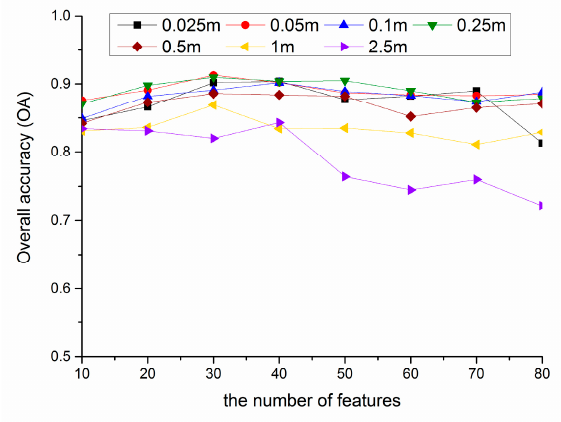
Figure 7. Overall accuracy (OA) of multi-scale images with different segmentation scales and feature numbers.